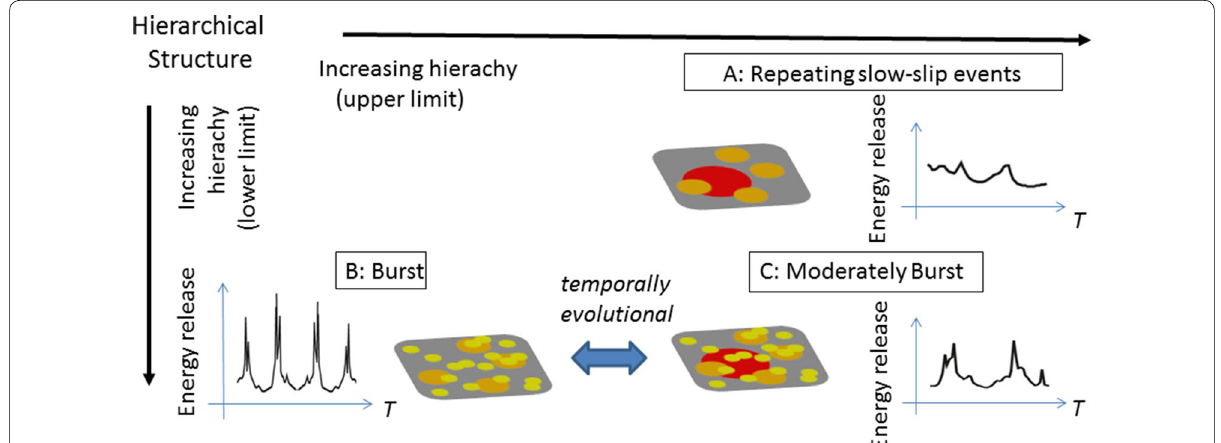
Fig. 14 Schematic illustration of fault hierarchy heterogeneity and different appearances of seismic behavior. a When the smallest scale is missed, the fault behavior appears as repeating slow slip events. b When the largest scale is missing (or there is a zero-stress background), burst seismicity controlled by small patches becomes dominant. c When the largest scale patch plays a strengthening role, the burst behavior is